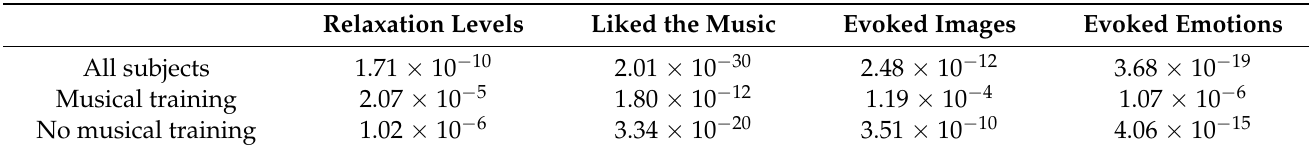
Table 1. Results of a two-tailed Mann–Whitney U-test comparing the Individualized Listening group with the Melomics- Health group: All Subjects, Subjects with musical training and Subjects without musical training.